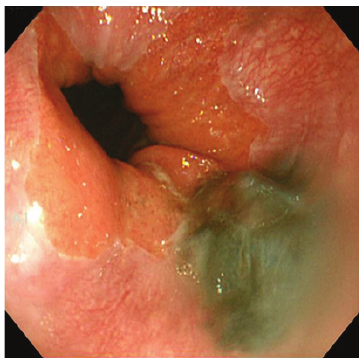
Figure 2: Esophagoscopy showing flat and black pigmented mucosal lesions with reflux esophagitis in close up of esophagogas- tric junction.